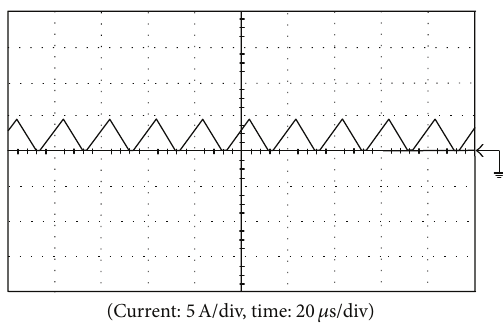
Figure 11: Simulated output inductor current while wind turbine provides 350 W.